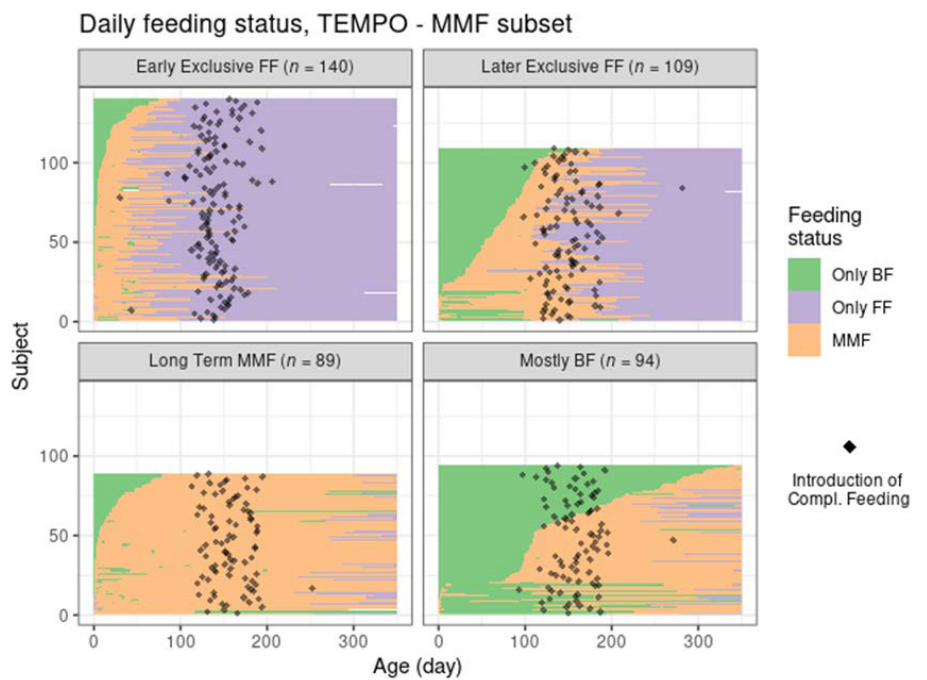
Figure 2. Feeding status trajectory for all MMF subjects in TEMPO per cluster. Each subject’s feeding pattern is represented by a horizontal line ranging from birth (leftmost) to 350 days of age (rightmost). The colour at each age describes whether the subject was exclusively BF, exclusively FF, or mixed feeding. The black dots indicate the recorded day of starting complementary feeding.